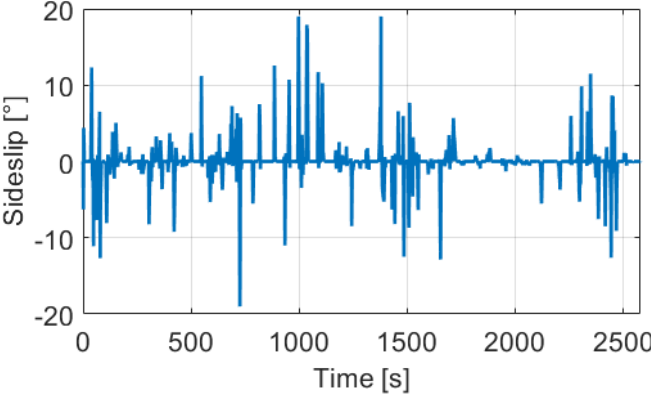
Figure 18. Estimated sideslip of the used